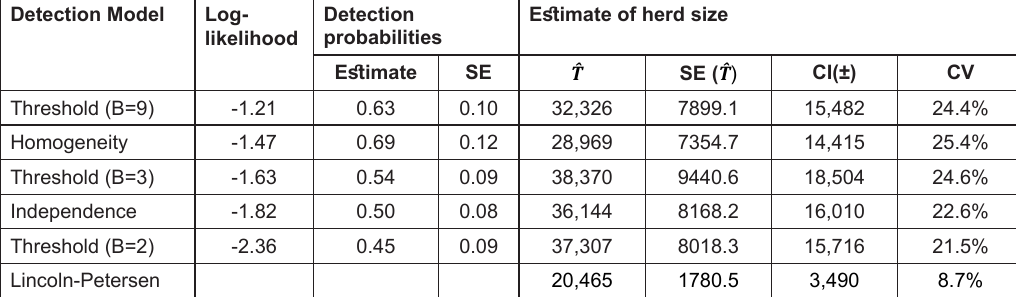
Table 17. Rivest Model estimates and LP estimate for Bluenose-West 2012